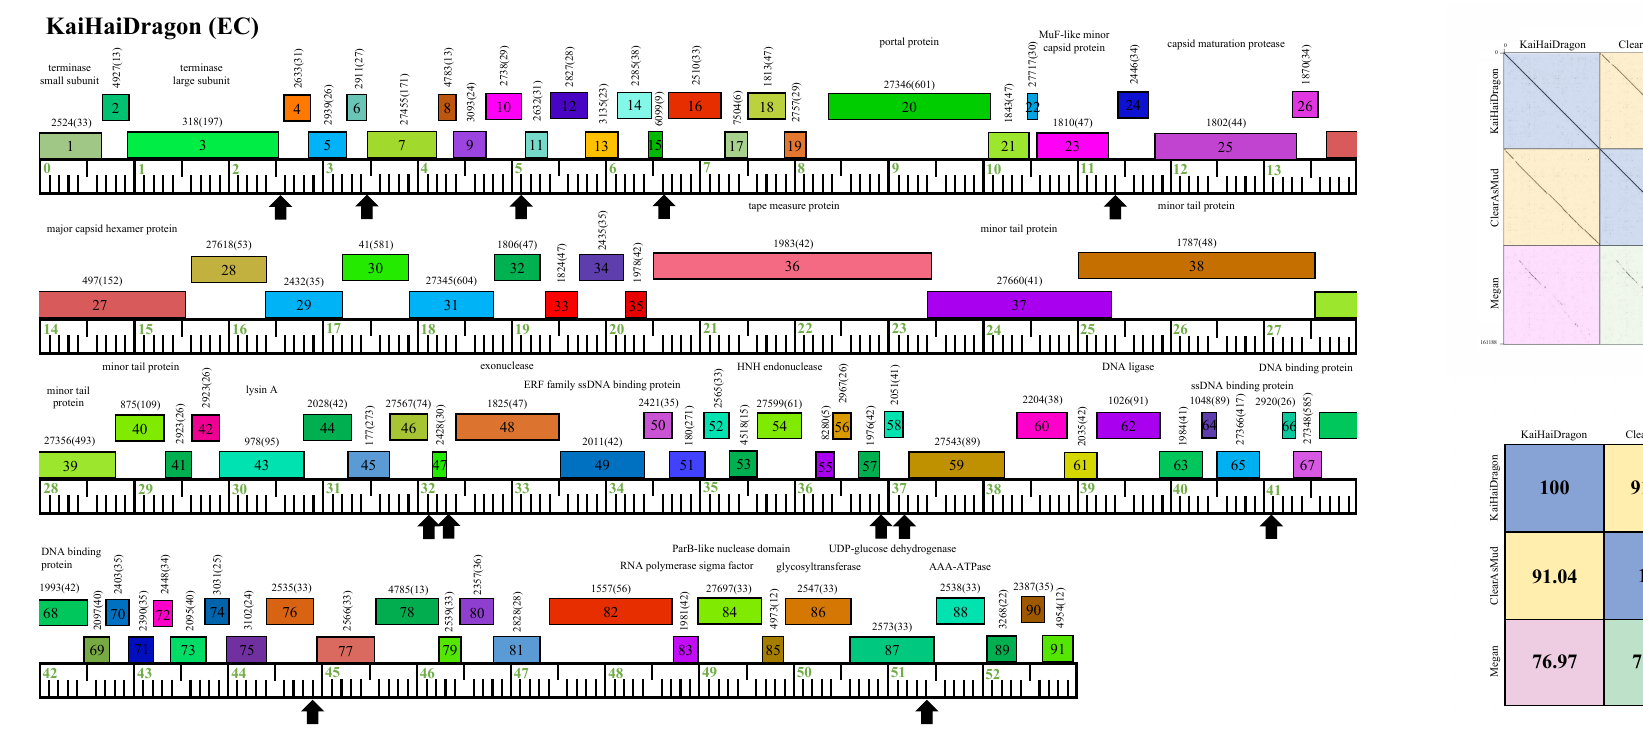
Figure 6. Genomic organization of Microbacterium Cluster EC phage KaiHaiDragon. ( A ) Whole genome organization of phage KaiHaiDragon. Genes are represented as boxes above the genome, reflecting rightwards-transcription. Genes are colored according to their phamily designations using Phamerator [13]. The phamily number, along with the number of members in the specific phamily in parentheses, are also written above the boxes. Black up arrows indicate the positions of conserved 18 bp asymmetric sequence motifs. ( B ) Dot plot and percent identity comparisons of KaiHaiDragon to two other Cluster EC phages, ClearAsMud and